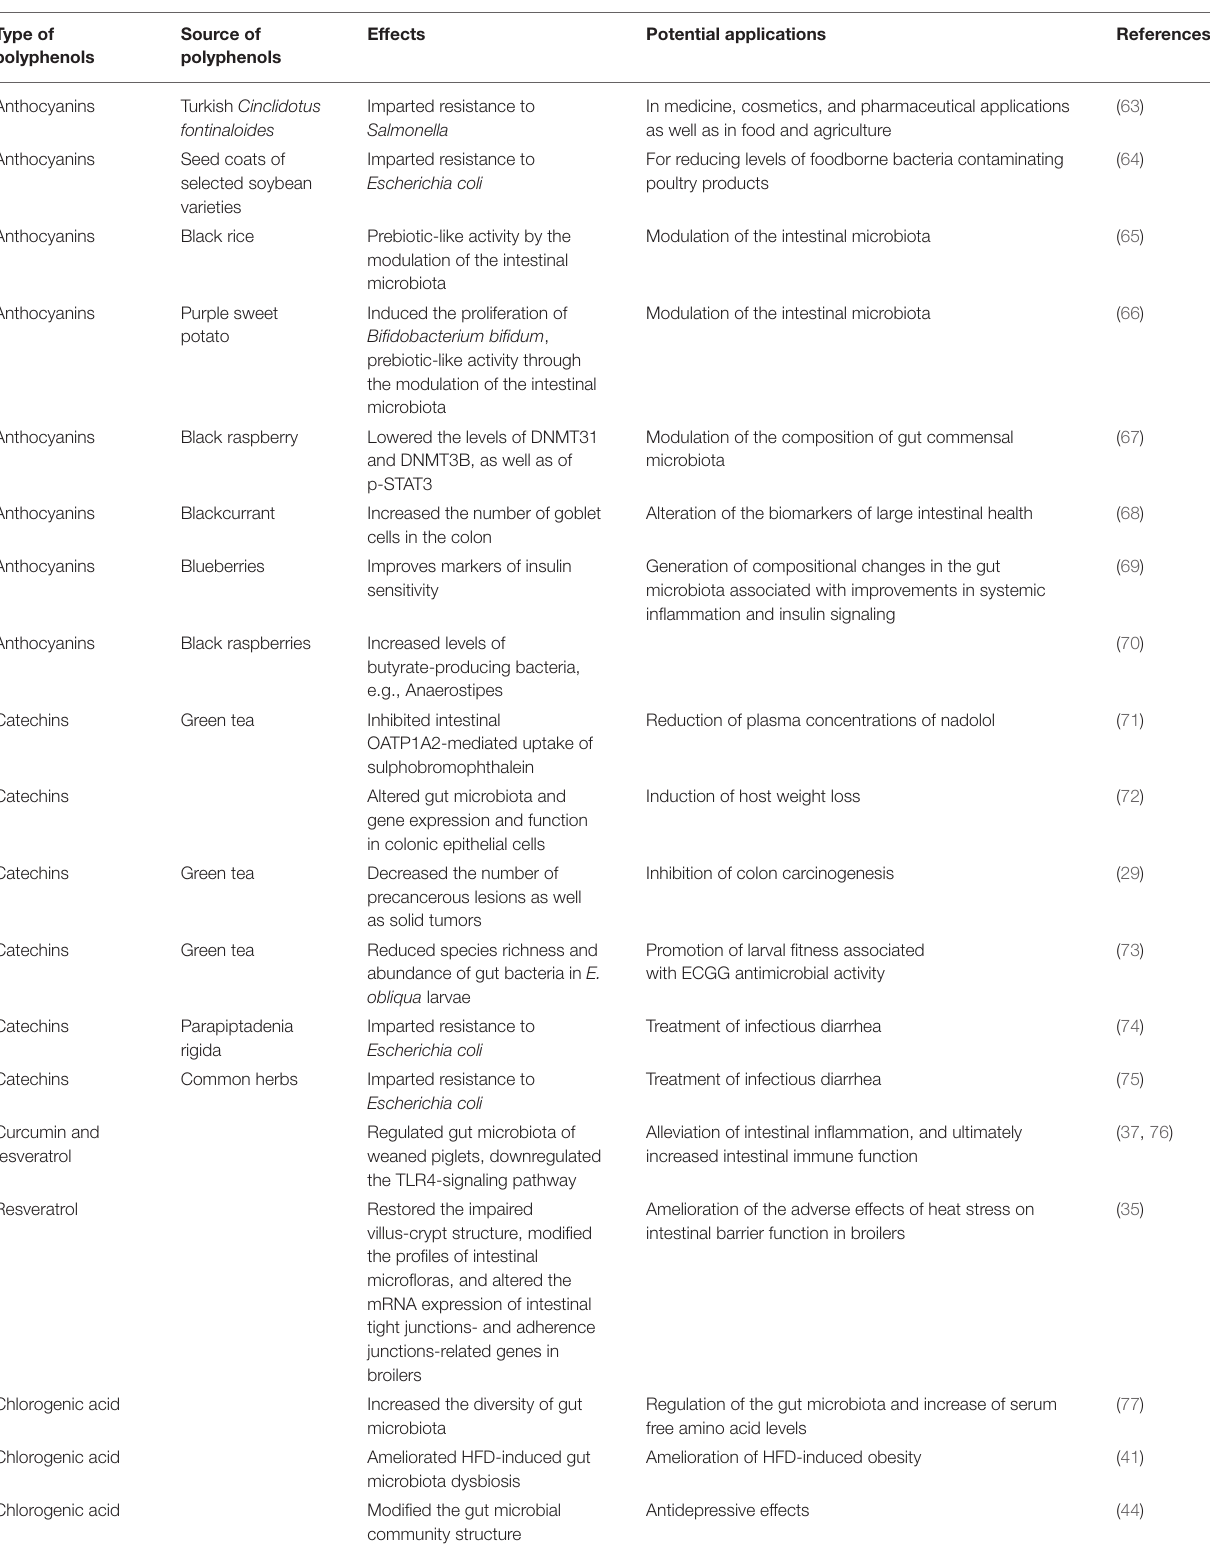
TABLE 1 | Recent studies on the effects of different polyphenols on intestinal